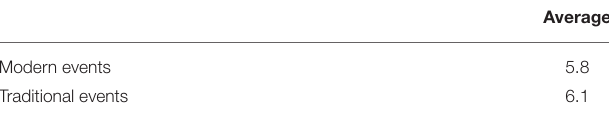
TABLE 5 | Level of positive emotions during events.